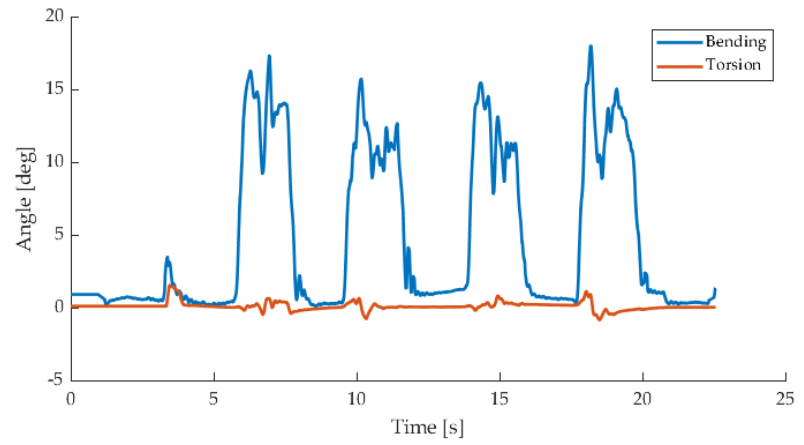
Figure 9. Orientation data acquired by the IMU on the upper torso and mapped as torso bending angle θ and axial torsion ∆ ϕ .